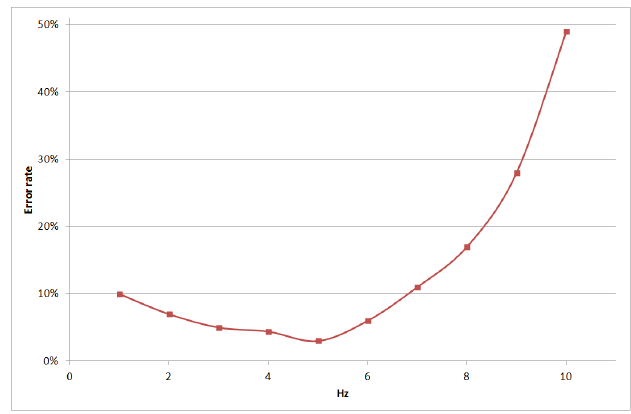
Figure 16. Error rate of the VLC message versus marker blinking frequency.